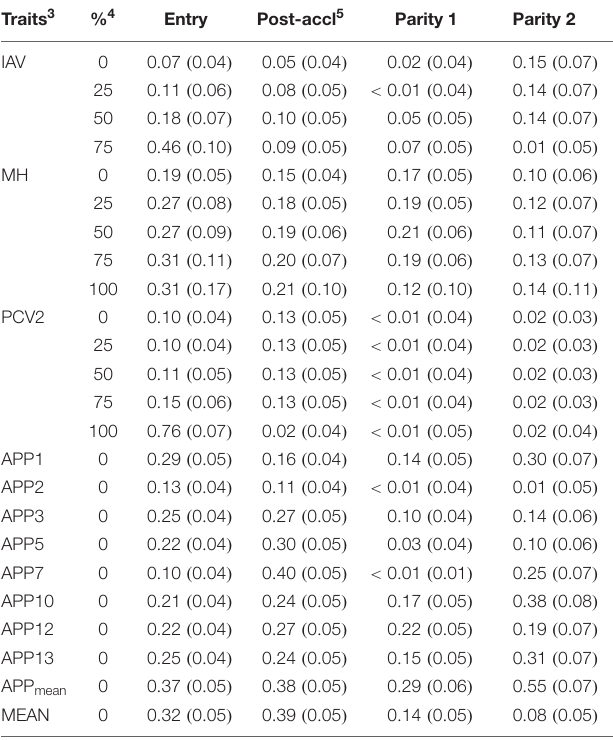
TABLE 3 | Heritability estimates 1 of antibody response to common infectious pathogens 2 in pigs by time-point. Traits